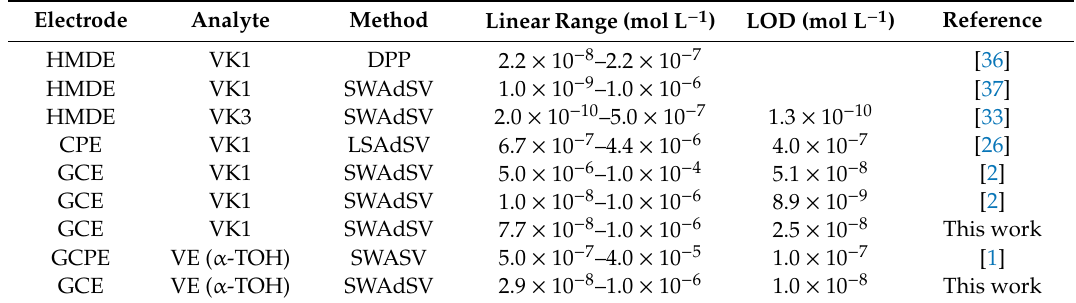
Table 1. Overview of stripping voltammetric methods for the determination of VK and vitamin E (VE).